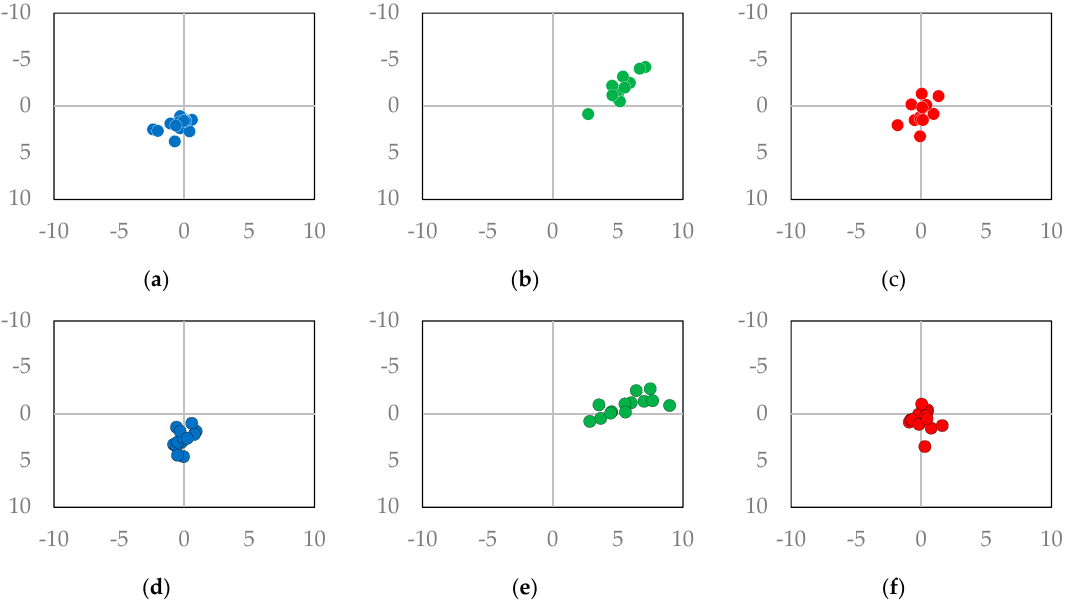
Figure 1. Sagittal (vertical axis) and horizontal (horizontal axis) components of the ball rotation of all participants: the result of the straight ( a ), curve ( b ) and knuckle ( c ) kicks in the pre experiment; the result of the straight ( d ), curve ( e ) and knuckle ( f ) kicks in the post